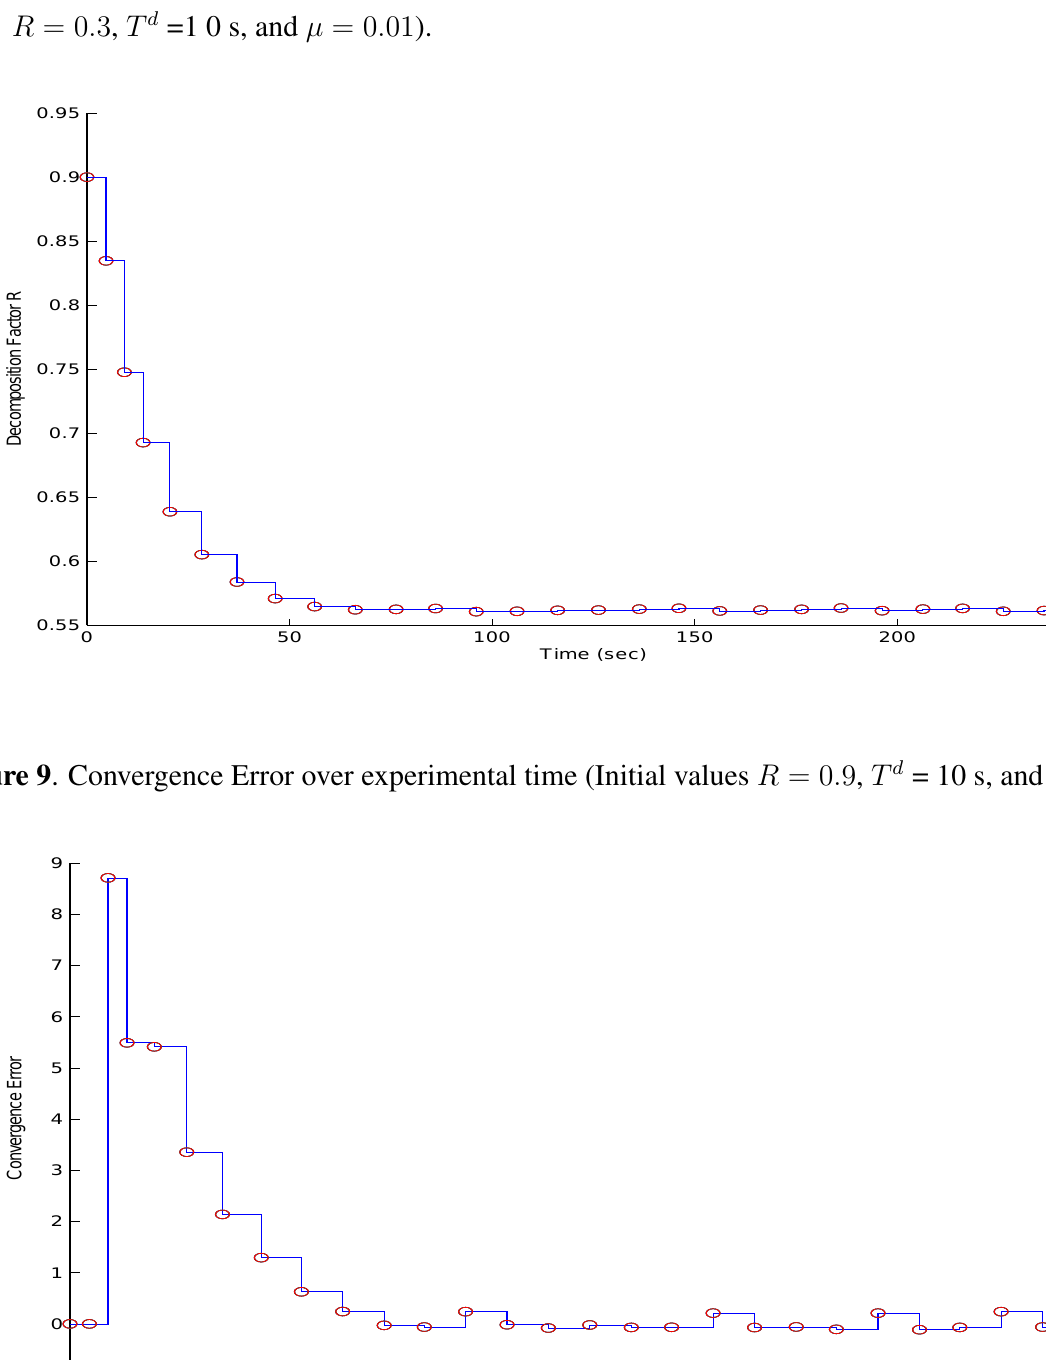
Figure 8 . QT–Decomposition factor R convergence over experimental time (Initial values